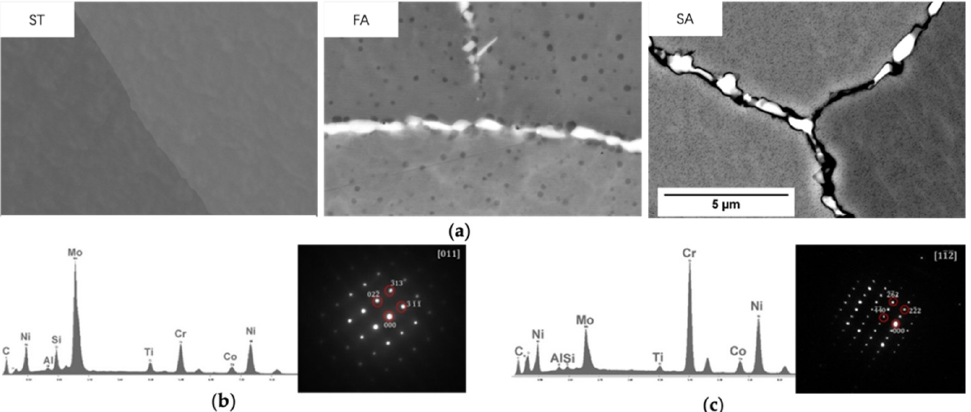
Figure 9. ( a ) Micrographs of grain boundary precipitates in ST, FA, SA condition; ( b ) EDS spectra and a diffraction pattern of white precipitate in FA sample; ( c ) EDS spectra and a diffraction pattern of dark precipitate in SA sample.